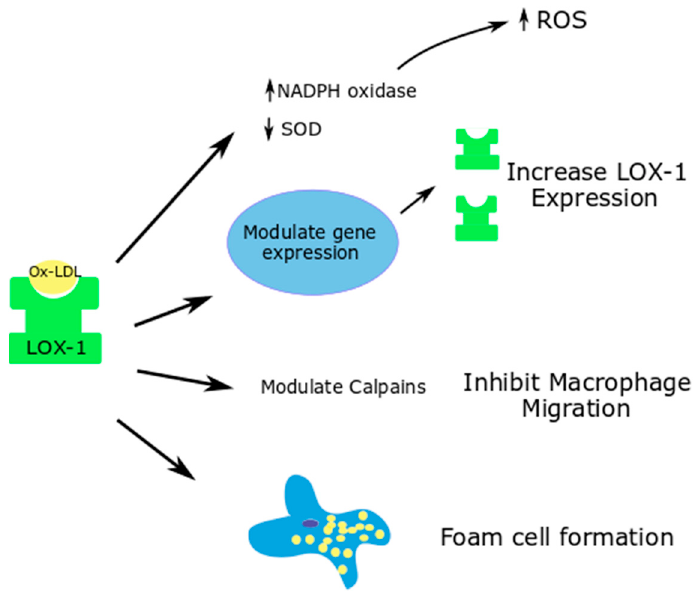
Figure 2. Effects of ox-LDL-LOX-1 interaction in macrophages; Superoxide dismutase—SOD.